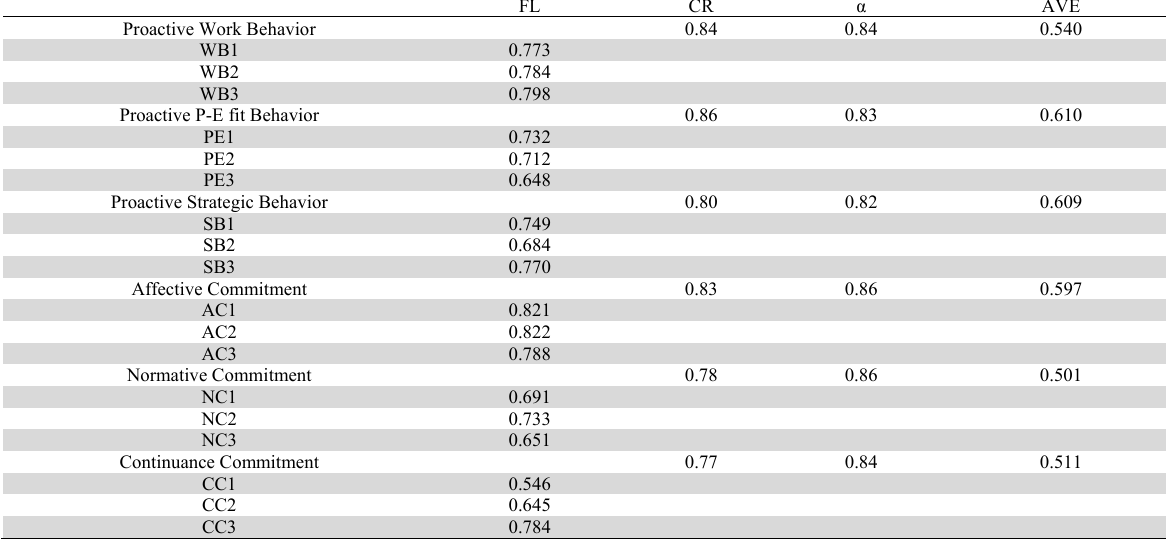
Loadings, AVE and Construct